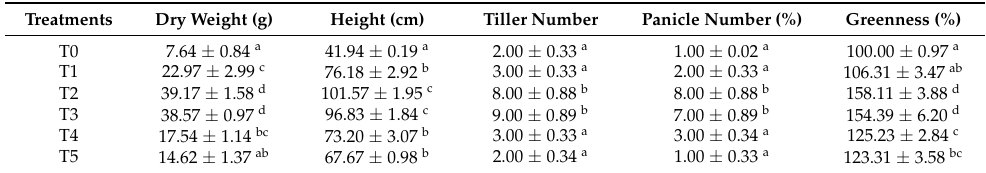
Table 10. Effects of RSRH biochar on dry weight, height, tiller number, panicle number, and greenness at harvest (70 DAT).